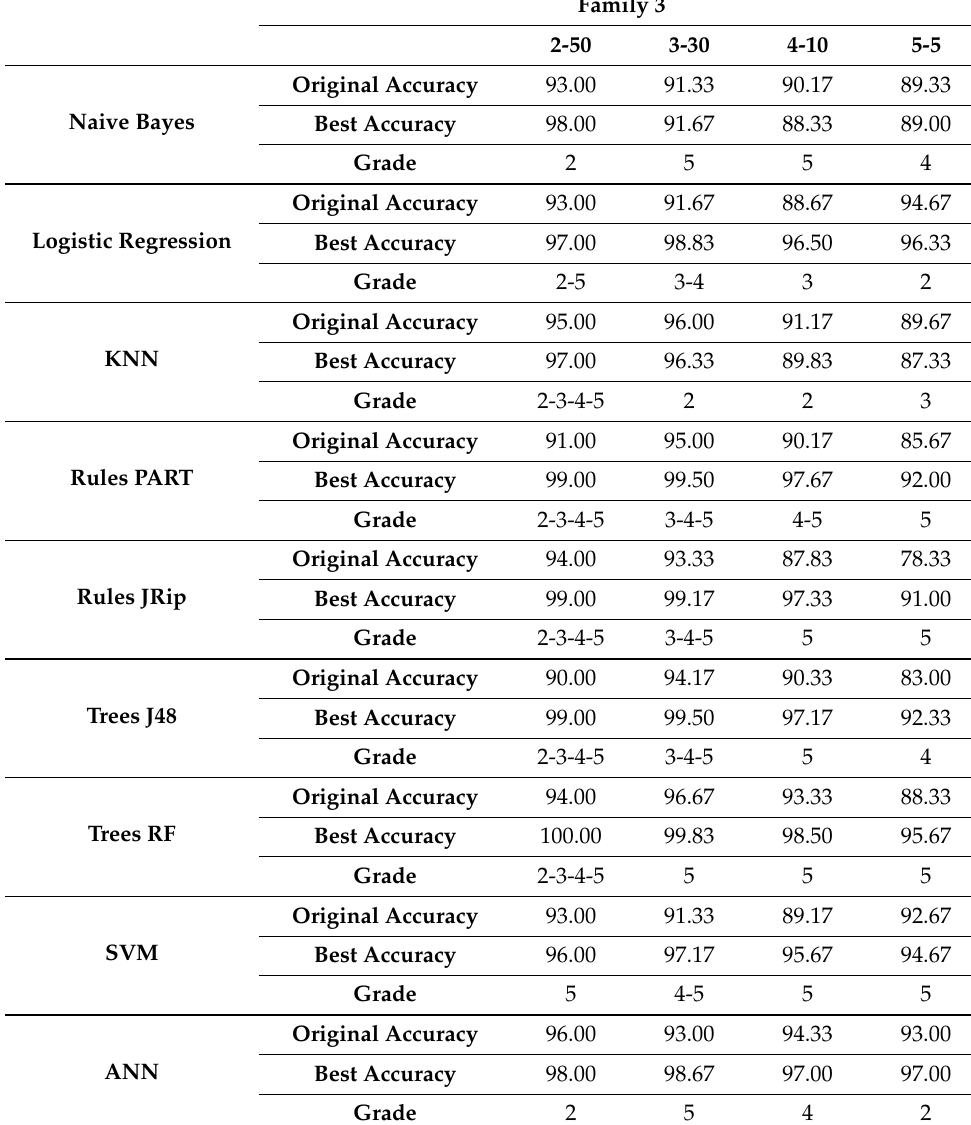
Table A3. Table corresponding to results of artificial data from Family 3.